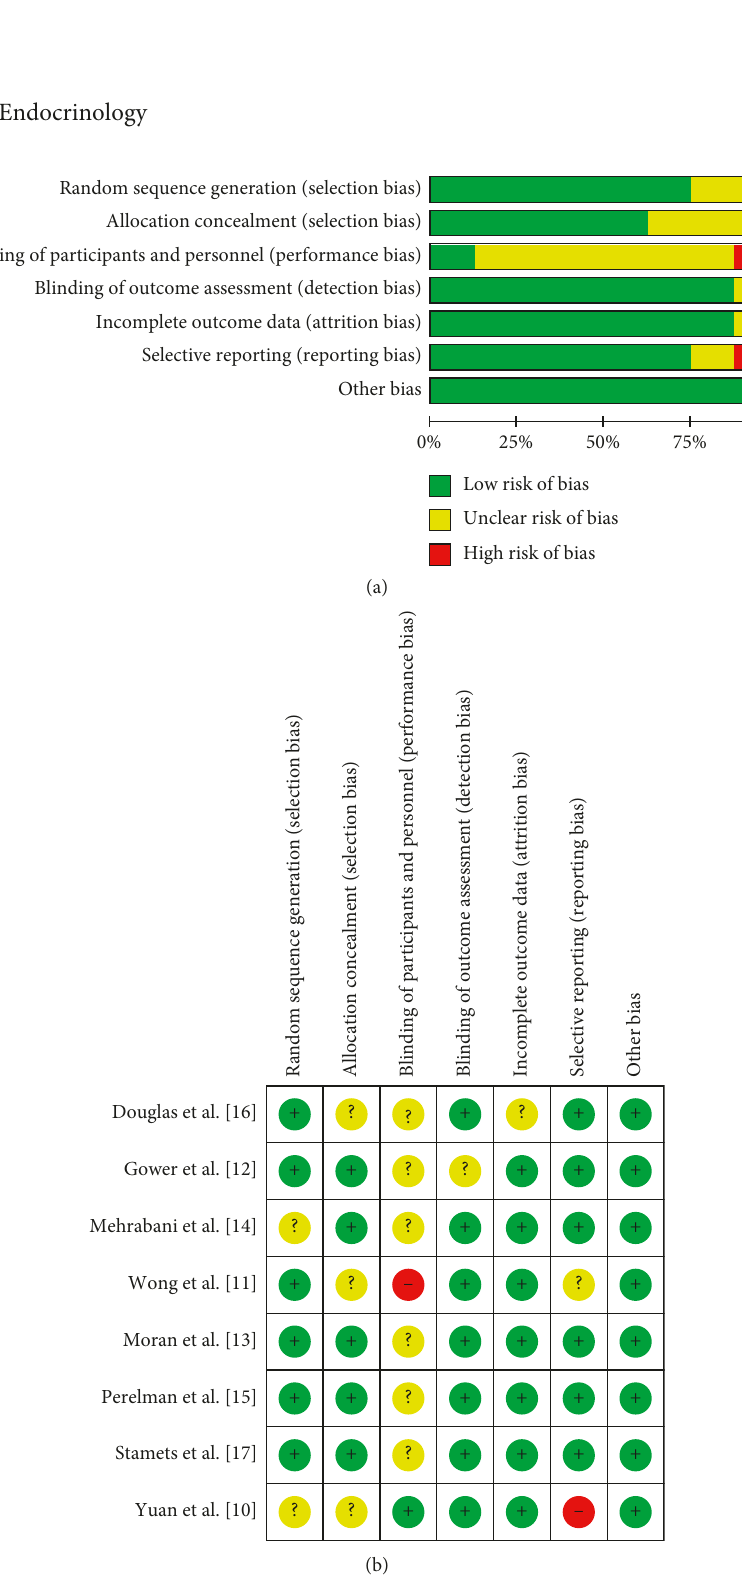
Figure 2: Graphical representation of the risk of bias in the selected